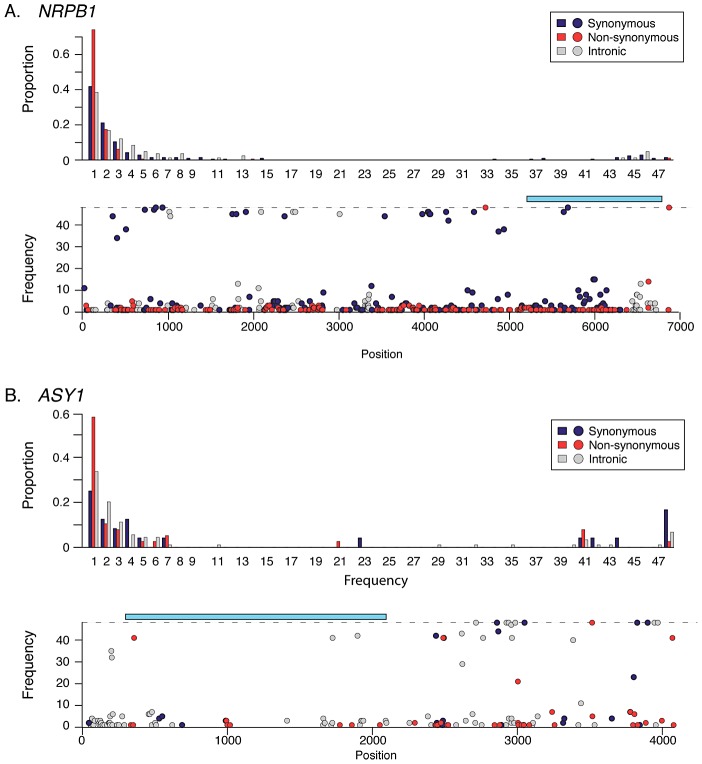
Site frequency spectra and SNP frequency for NRPB1 and ASY1.(A) Polymorphism in NRPB1. Top graph shows unfolded SFS (top graph) relative to A. lyrata. Lower graph shows SNP frequencies along the gene's length relative to A. lyrata and A. thaliana. Light blue rectangle indicates region coding for C-terminal heptad repeat tail. (B) Polymorphism in ASY1. Top graph shows unfolded SFS (top graph) relative to A. lyrata. Lower graph shows SNP frequencies along the gene's length relative to A. lyrata and A. thaliana. Light blue rectangle indicates region encoding conserved HORMA domain. Non-synonymous sites are shown in red, synonymous in dark blue, and intronic sites in grey.